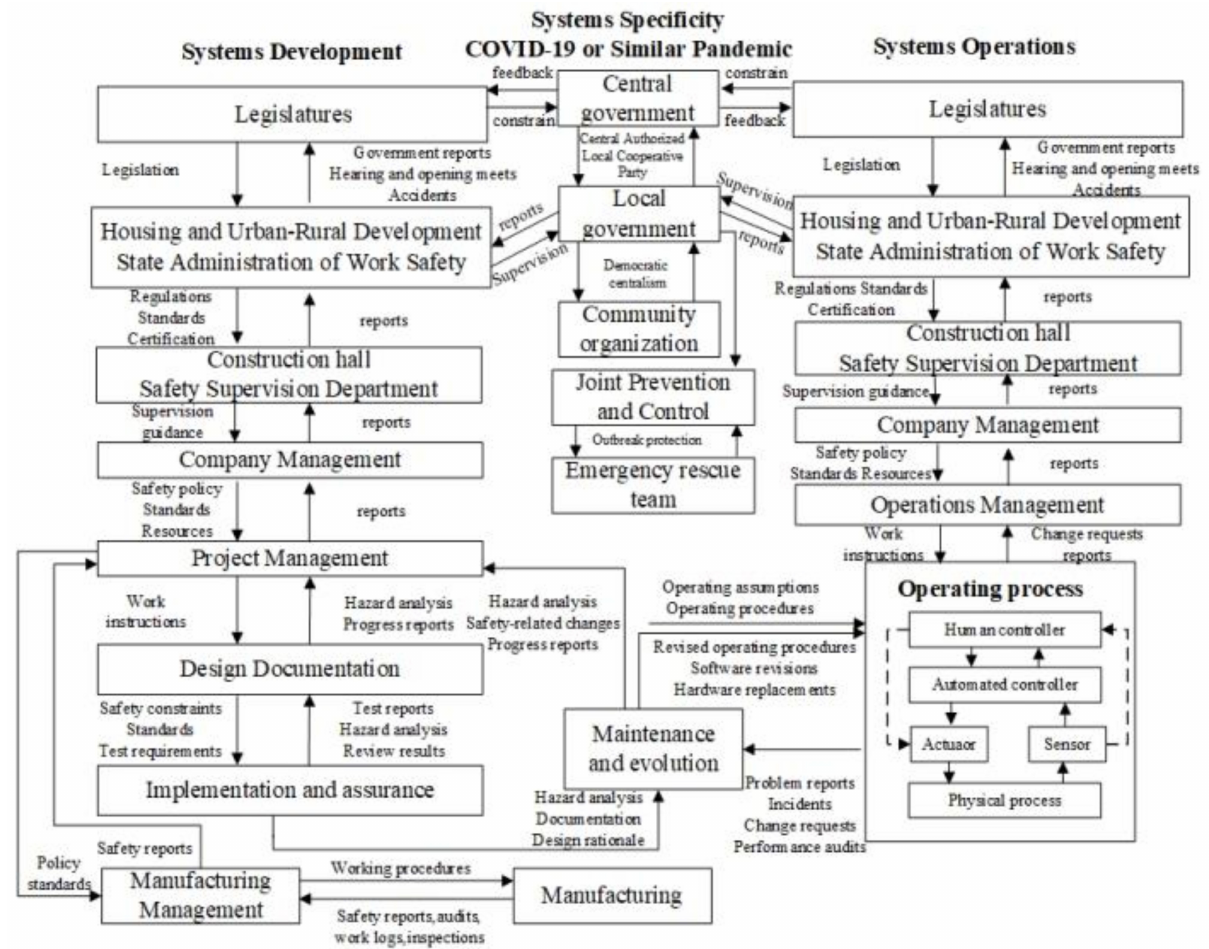
Figure 3. The hierarchical safety control structure of the improved STAMP combined with